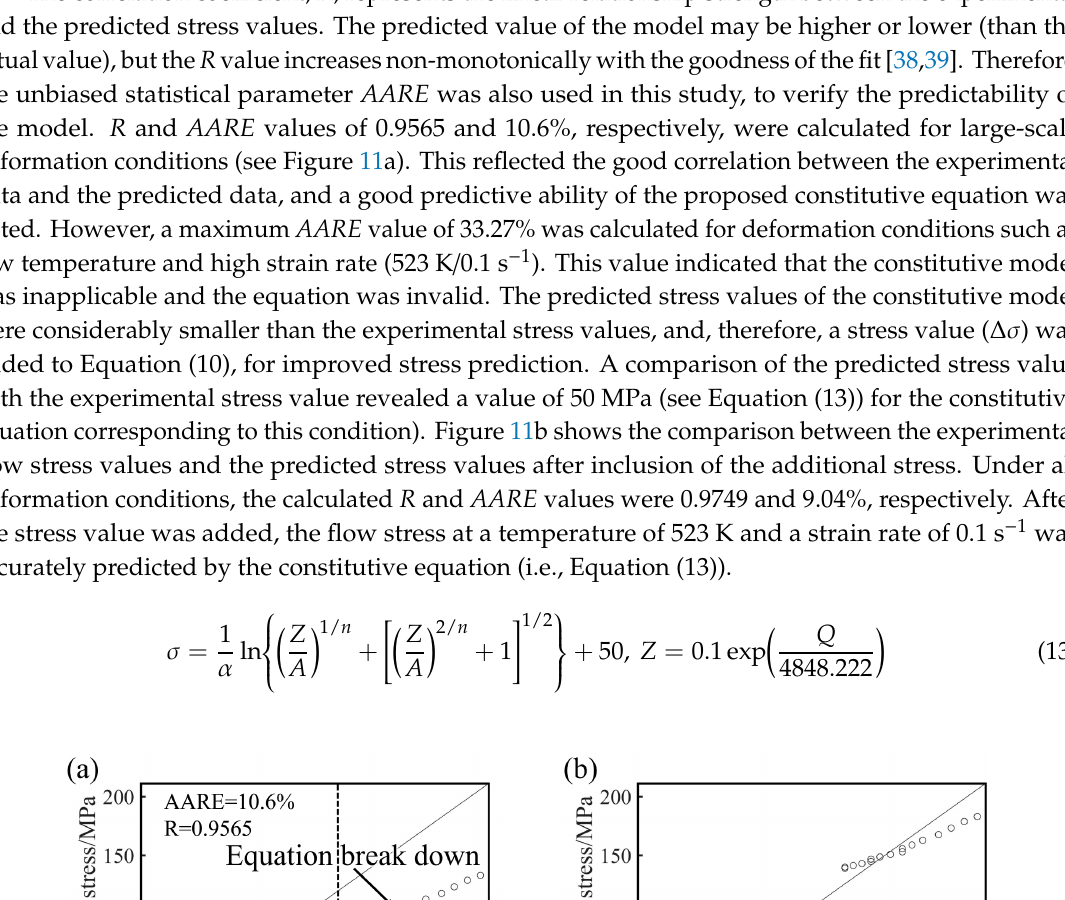
Figure 12. Typical θ – σ plot obtained at 673 K and 0.1 s − 1 . Poliak and Jonas [10] proposed a method of determining the critical condition required for DRX by considering the inflection point of strain hardening rate θ – σ ( θ = d σ /d ε ) relation curves. For accuracy of the calculation, the second derivative method was used to obtain the minimum values of ( − d θ /d σ )– σ relation curves as the critical stress values of DRX, and the corresponding critical strain values were calculated. Figure 13 shows the relation curves between the θ and σ of Mg-16Al Mg alloy under certain deformation conditions. In this study, the critical strain and critical stress values under different deformation conditions were determined via the second derivative method.